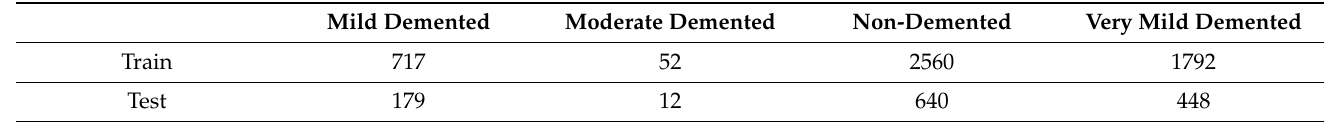
Table 2. Distribution of the records in the dataset used in this work.